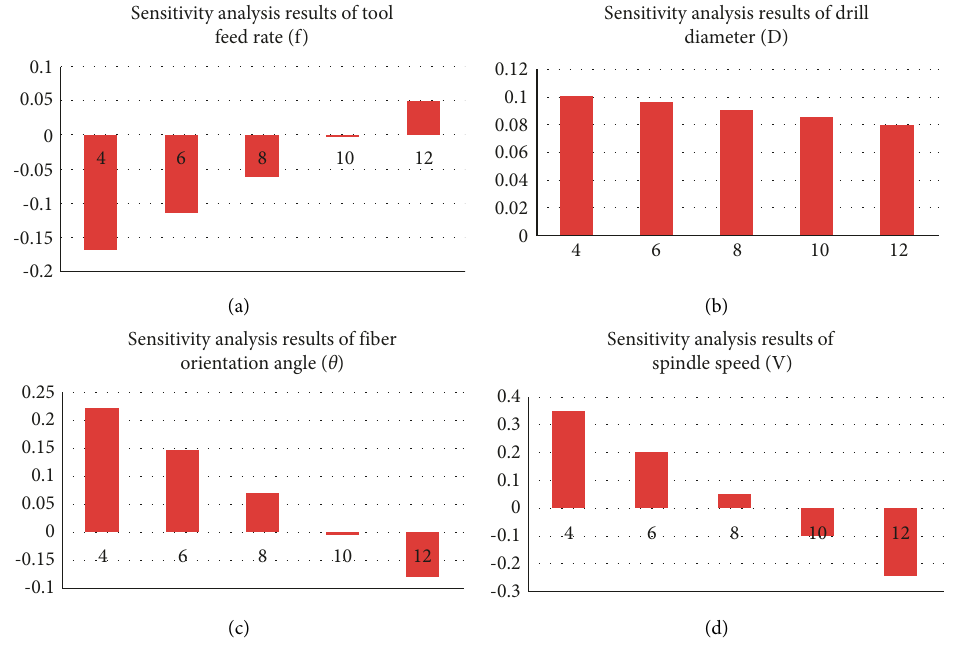
Figure 4: Sensitivity analysis of (a) tool feed rate, (b) (f) drill diameter, (c) orientation angle, and (d) spindle